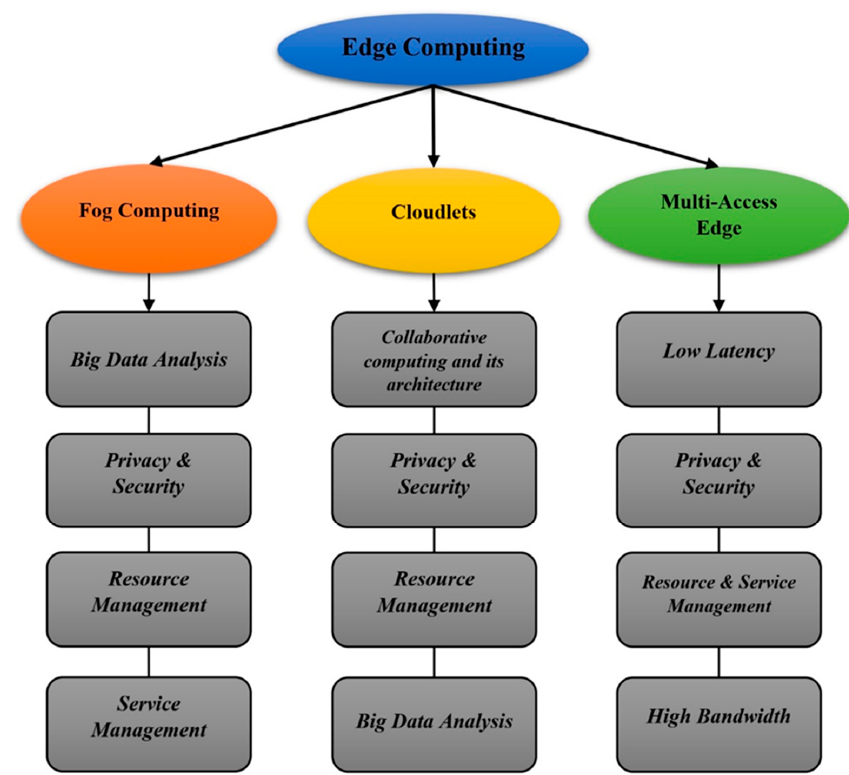
Figure 6. Edge computing